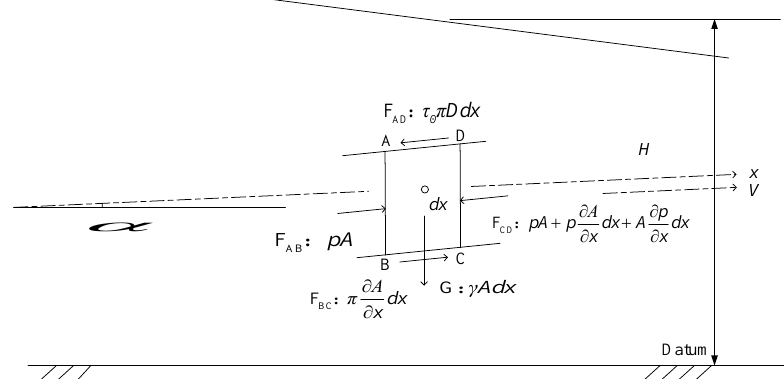
Figure 2. Force diagram of the micro-water body in the pressure pipeline.